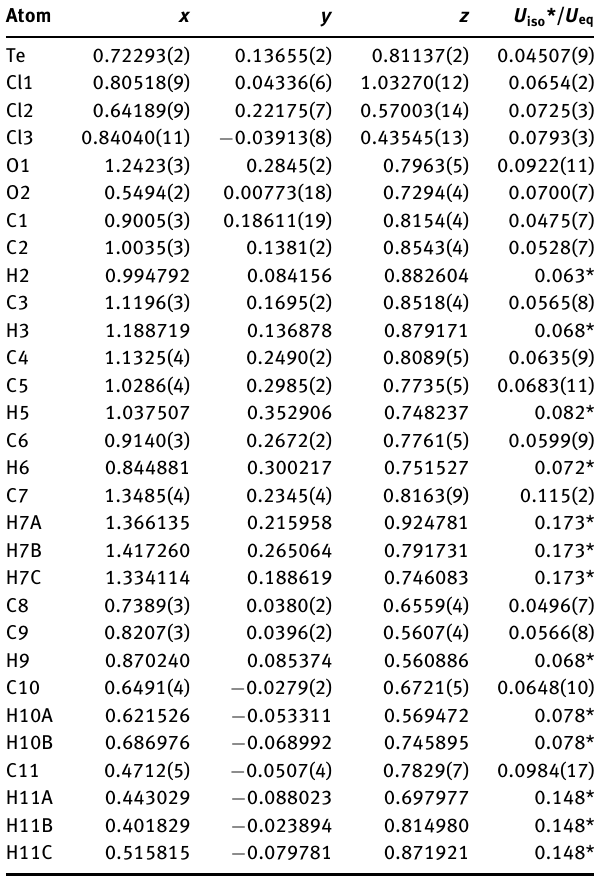
Table 2: Fractional atomic coordinates and isotropic or equivalent isotropic displacement parameters (Å 2